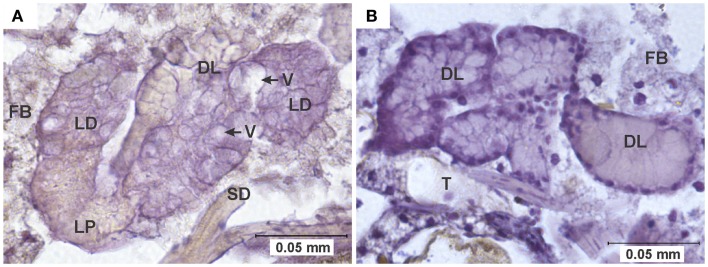
Pathology in salivary glands. (A) Salivary gland of a specimen of the HVP strain, 7 days after ingesting a blood meal containing 5-log PFU of WEEV per 0.1 ml blood. Notice the extensive cytoplasmic vacuolation of acinar cells, and the absence of staining indicative of viral antigen. (B) Comparable section of a normal salivary gland from an uninfected control. DL, distal lobe; FB, fat body; LD, lateral-distal lobe; LP, lateral-proximal lobe; SD, salivary duct; T, trachea; V, vacuole.